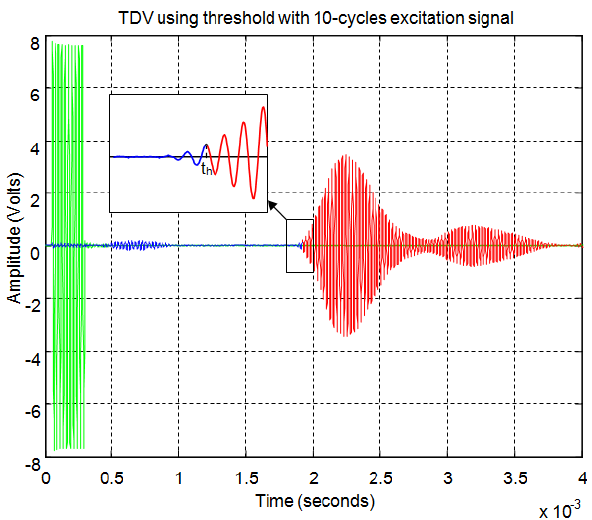
Figure 22. Start time using threshold for an echo formed by two overlapping sub-echoes.